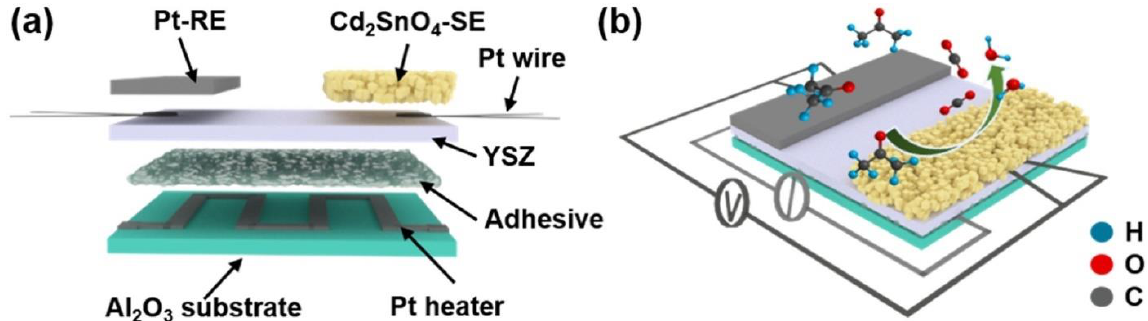
Figure 7. ( a ) Structure of the planar-type YSZ-based sensor and ( b ) schematic diagram of the measurement [30].